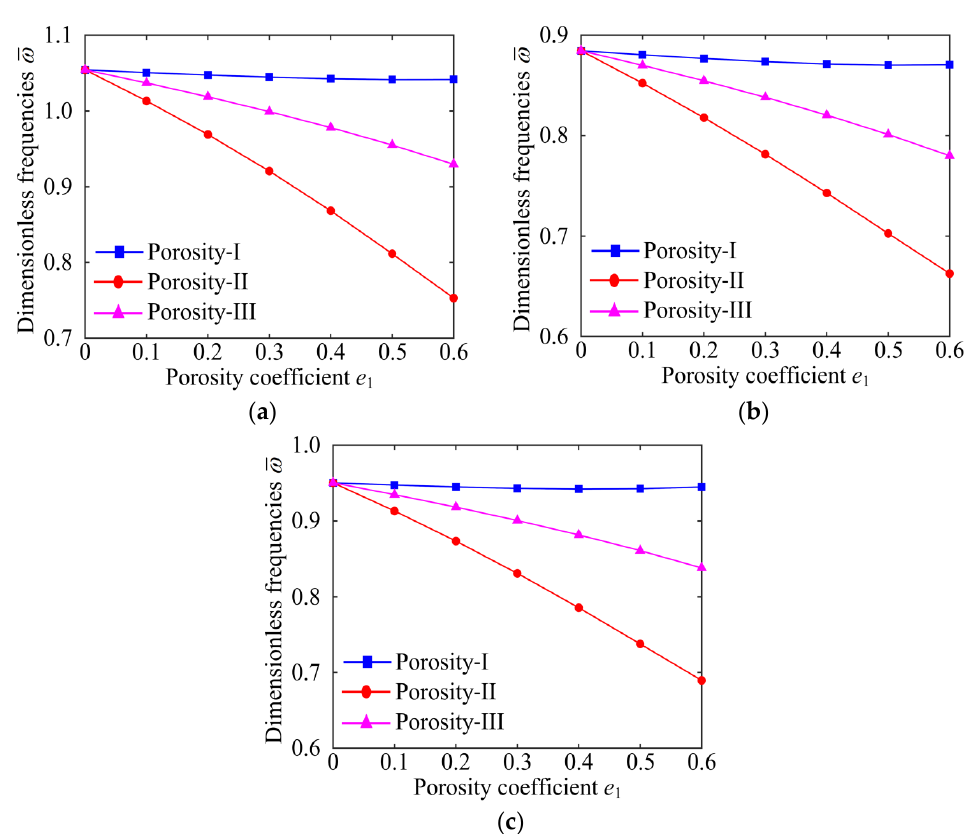
Figure 7. The influences of porosity coefficient on dimensionless fundamental frequencies of the GPLRP, two-cylindrical-panel system (SSSS). ( a ) GPL A; ( b ) GPL B; ( c ) GPL C.